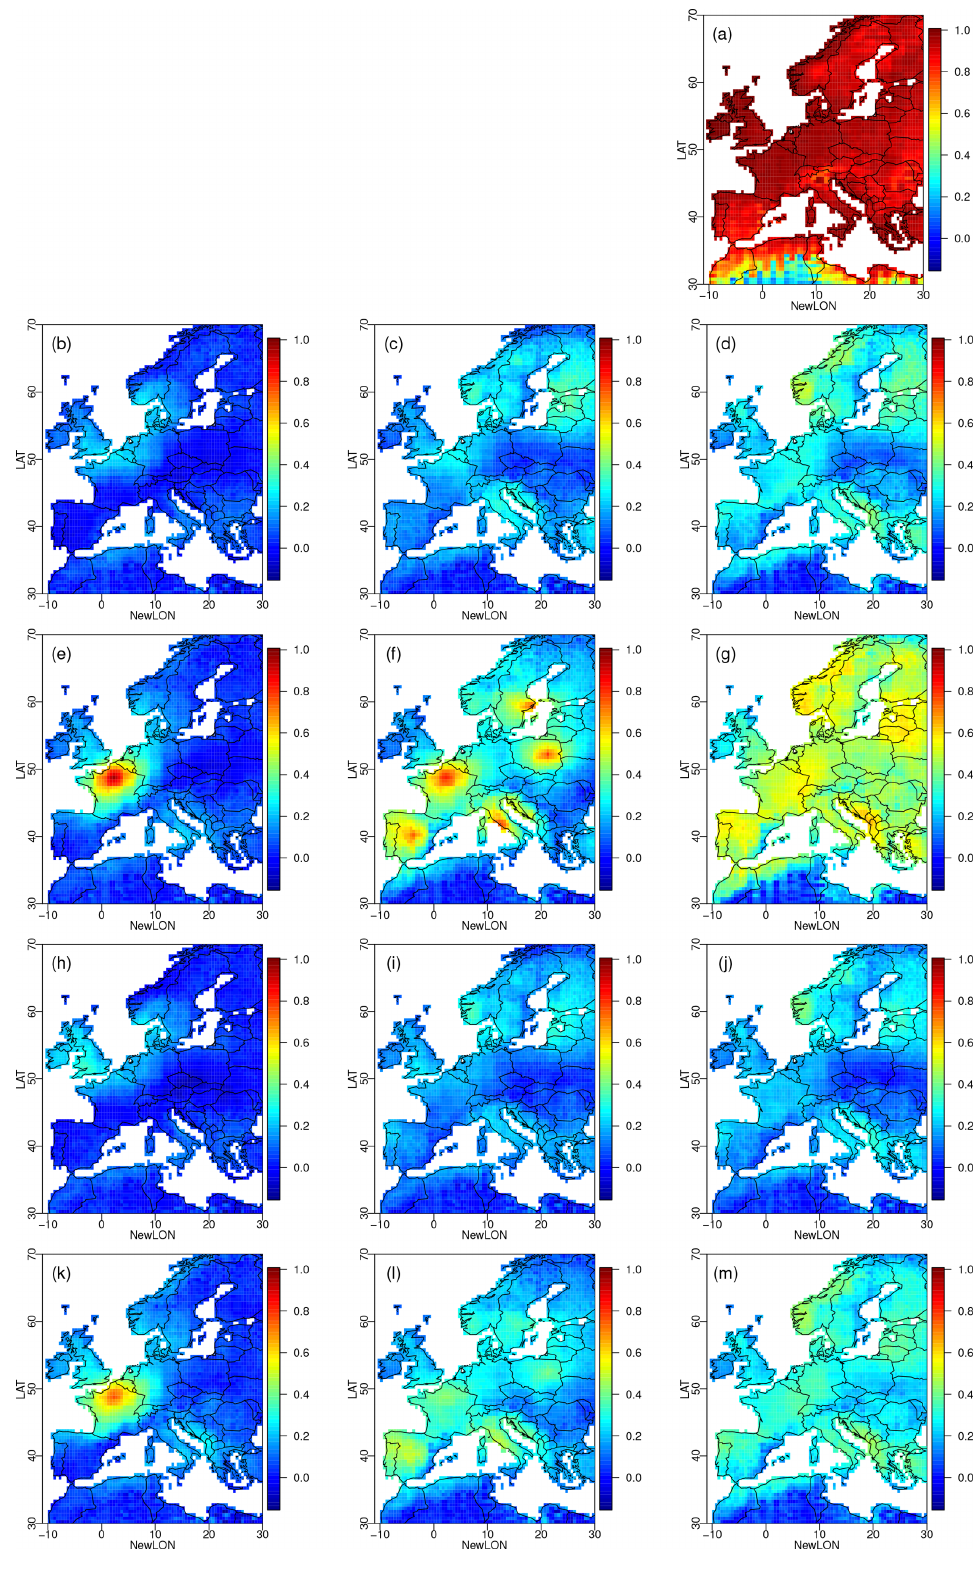
Figure 5. Same as Fig. 4 but for